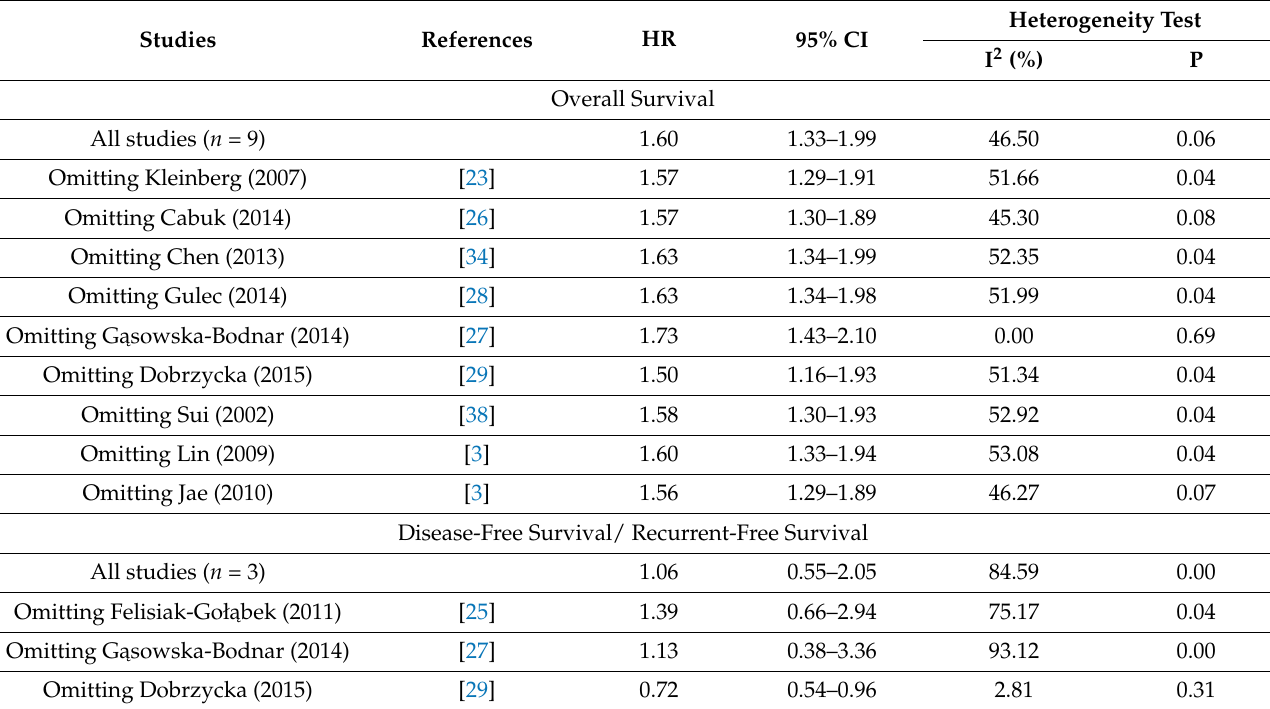
Table 2. Analysis sensitive for overall survival and disease-free survival/relapse (DFS/RFS).